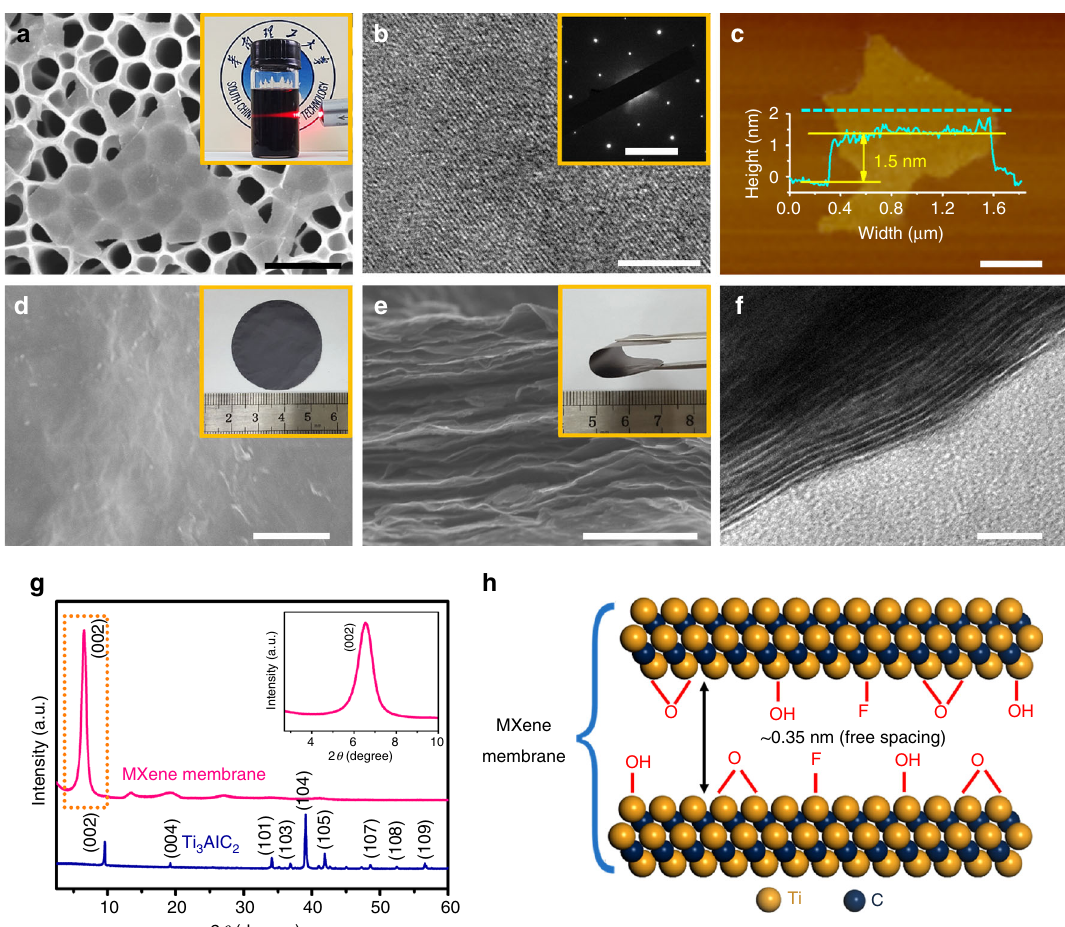
Fig. 1 Morphology and structure of exfoliated MXene (Ti 3 C 2 T X ) nanosheets and stacked MXene membrane. a SEM image of the delaminated MXene nanosheets on porous anodic aluminum oxide (AAO) (scale bar, 1 μ m). Inset is the Tyndall scattering effect in MXene colloidal solution in water. b HRTEM image of the MXene nanosheet with SAED pattern in the inset (scale bar, 5 nm, inset b , 5 nm − 1 ). c AFM image of the MXene nanosheet on cleaved mica. The height pro fi le of the nanosheet corresponds to the blue dashed line (scale bar, 500 nm). Note that the adsorbed molecules, such as H 2 O, also contribute the detected thickness of 1.5 nm. d SEM image of the MXene membrane surface (scale bar, 500 nm). Inset is a photograph of a MXene membrane. e Cross-sectional SEM image of the MXene membrane (scale bar, 1 μ m). Inset is a tweezer bent membrane. f Cross-sectional TEM image of the MXene membrane with 2D channels (scale bar, 10 nm). g XRD patterns of the MAX (Ti 3 AlC 2 ) powder and MXene (Ti 3 C 2 T X ) membrane with inset of the magni fi ed XRD pattern at low Bragg angles. h Illustration of the spacing between the neighboring MXene nanosheets in the